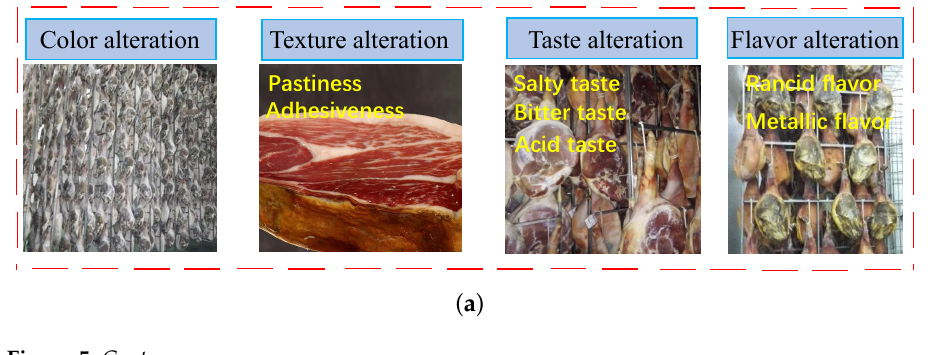
Figure1 The common quality defects in dry-cured ham Figure 5. Cont